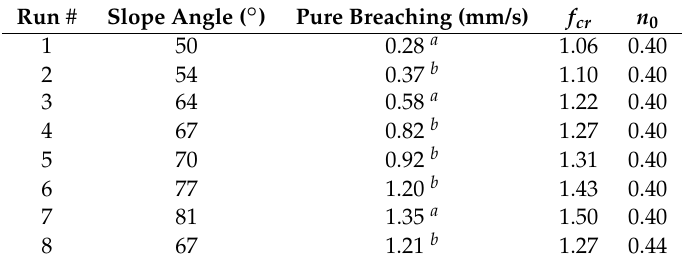
Table 2. Initial conditions of the numerical runs.